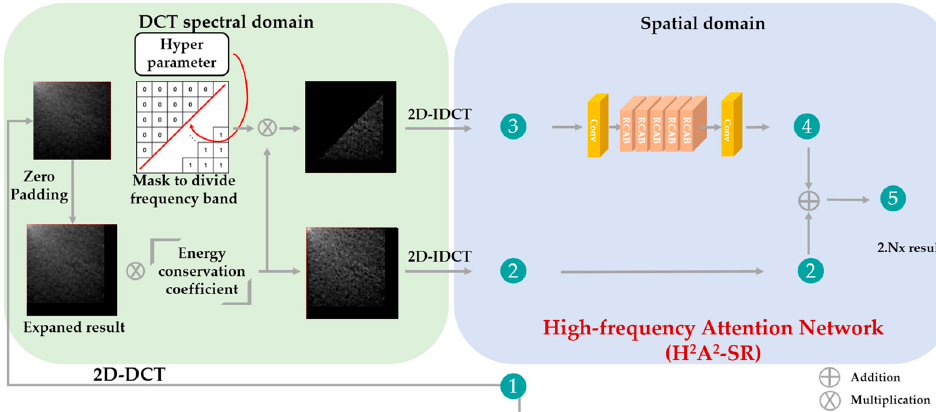
Figure 12. Flowchart of H 2 A 2 -SR’s steps. Each number represents a step in H 2 A 2 -SR.